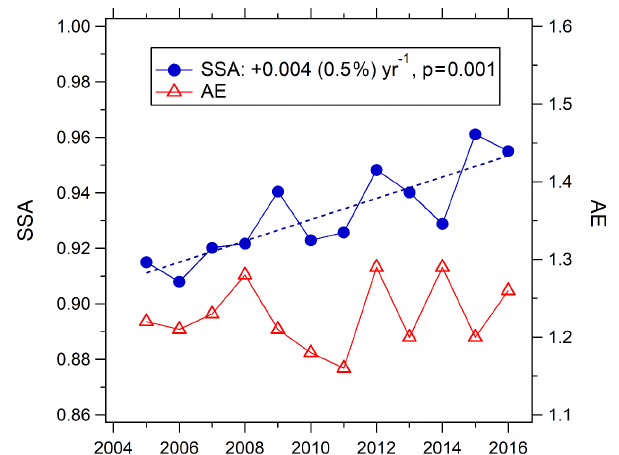
Figure 8. Variation in monthly-mean single scattering albedo (SSA) and Ångström exponent (AE) in Beijing for the month of August during